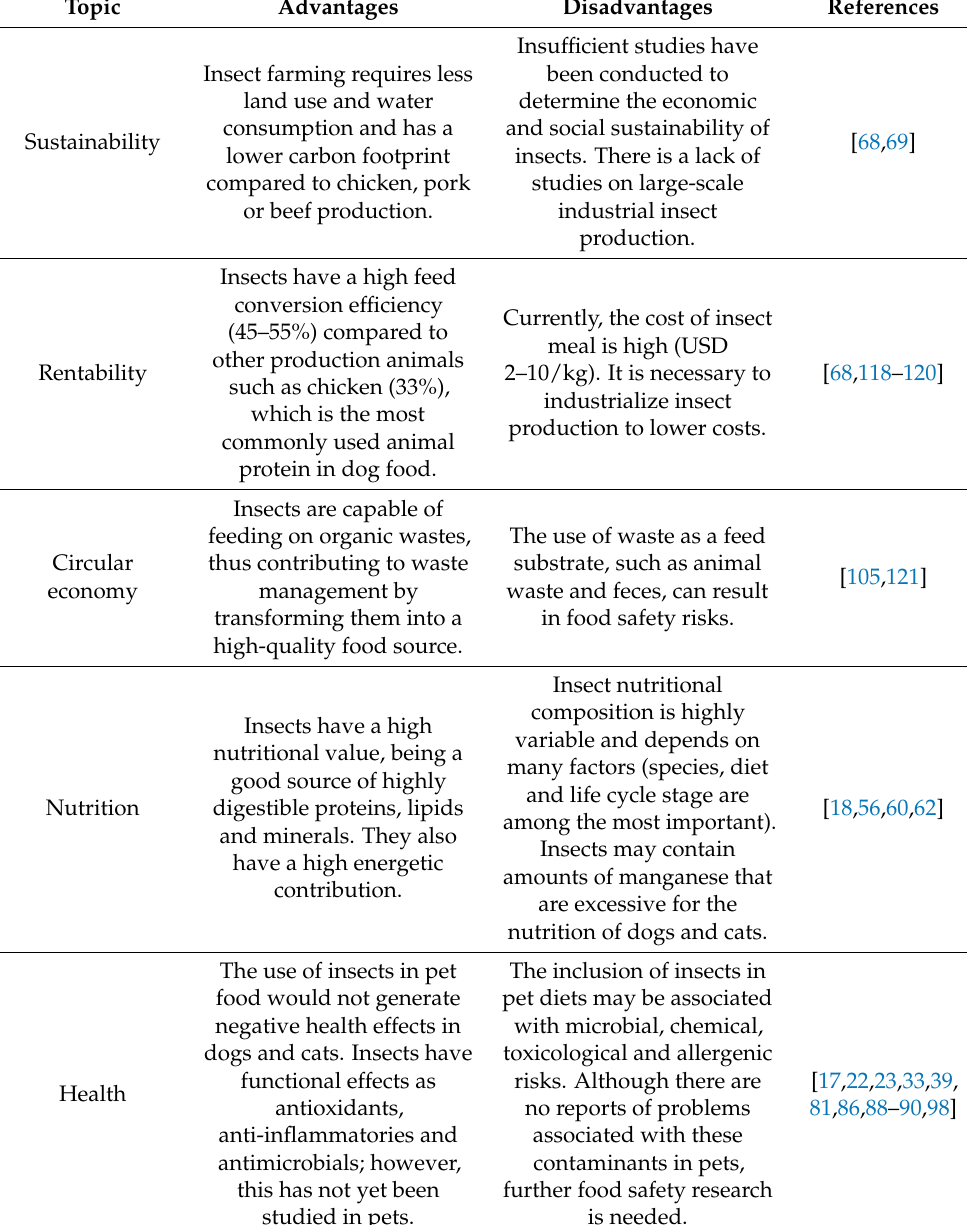
Table 4. Advantages and disadvantages of using insects in dog and cat